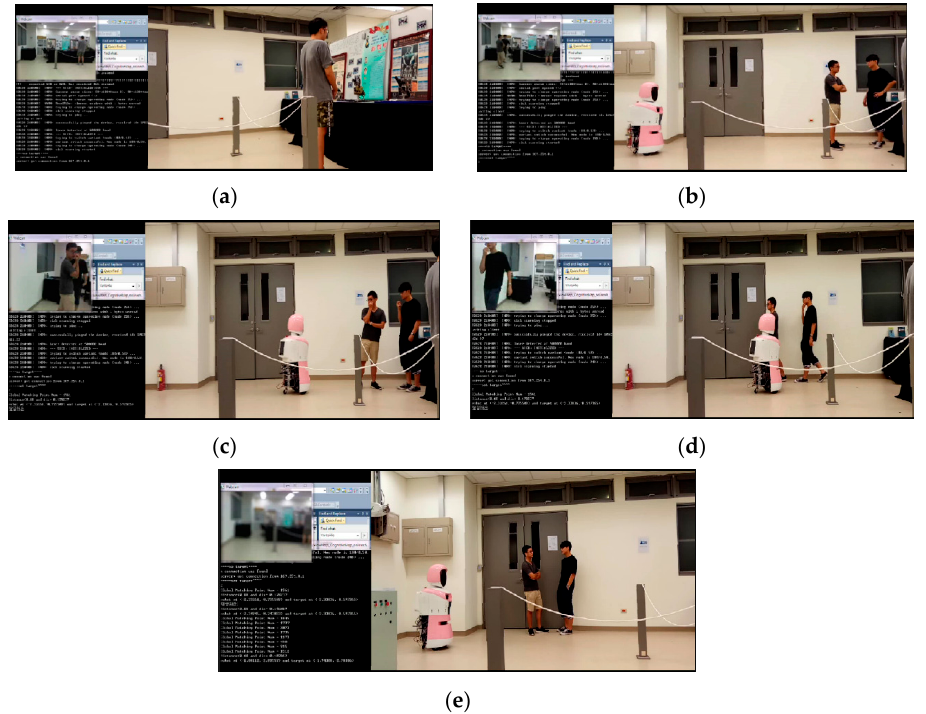
Figure 14. Scenario of some visitors obstructing the tour path ( a ) A visitor looks the exhibit at 4 s ( b ) Two visitors obstruct the path at 13 s. ( c ) Bunny detects the abnormal behavior and asks two visitors to leave at 26 s. ( d ) Two visitors move to other location at 32 s. ( e ) Bunny goes back the original position at 70 s (sec).